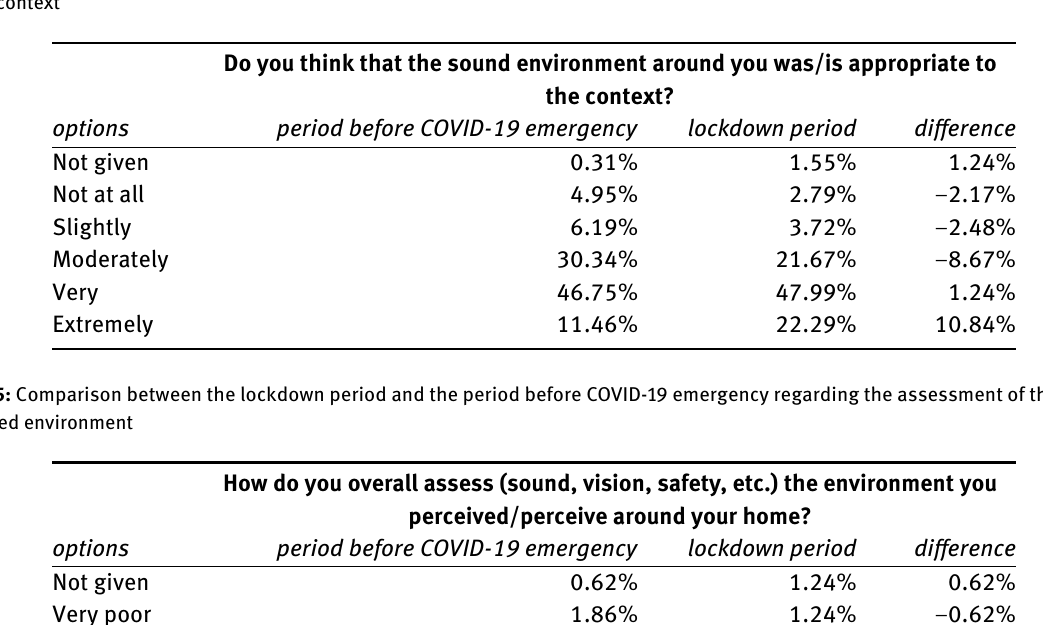
Table 14: Comparison between the lockdown period and the period before COVID-19 emergency regarding how the soundscape is suitable for the context